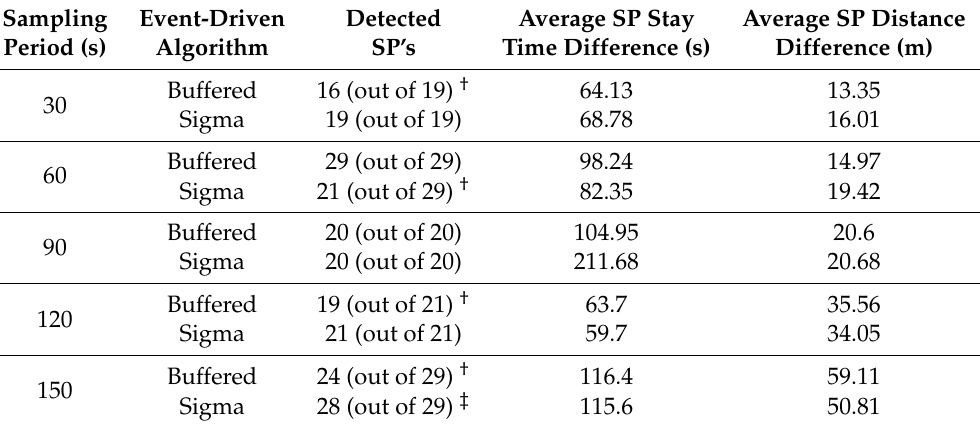
Table 2. Spatial and time accuracy observed in results of first experiment (SP = stay